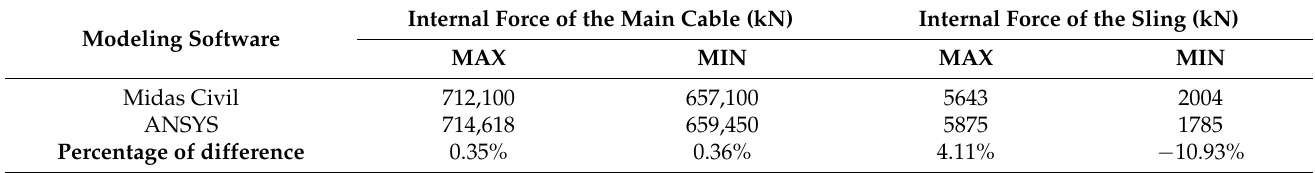
Table 2. Comparison of main cable Internal force and sling Internal force results.